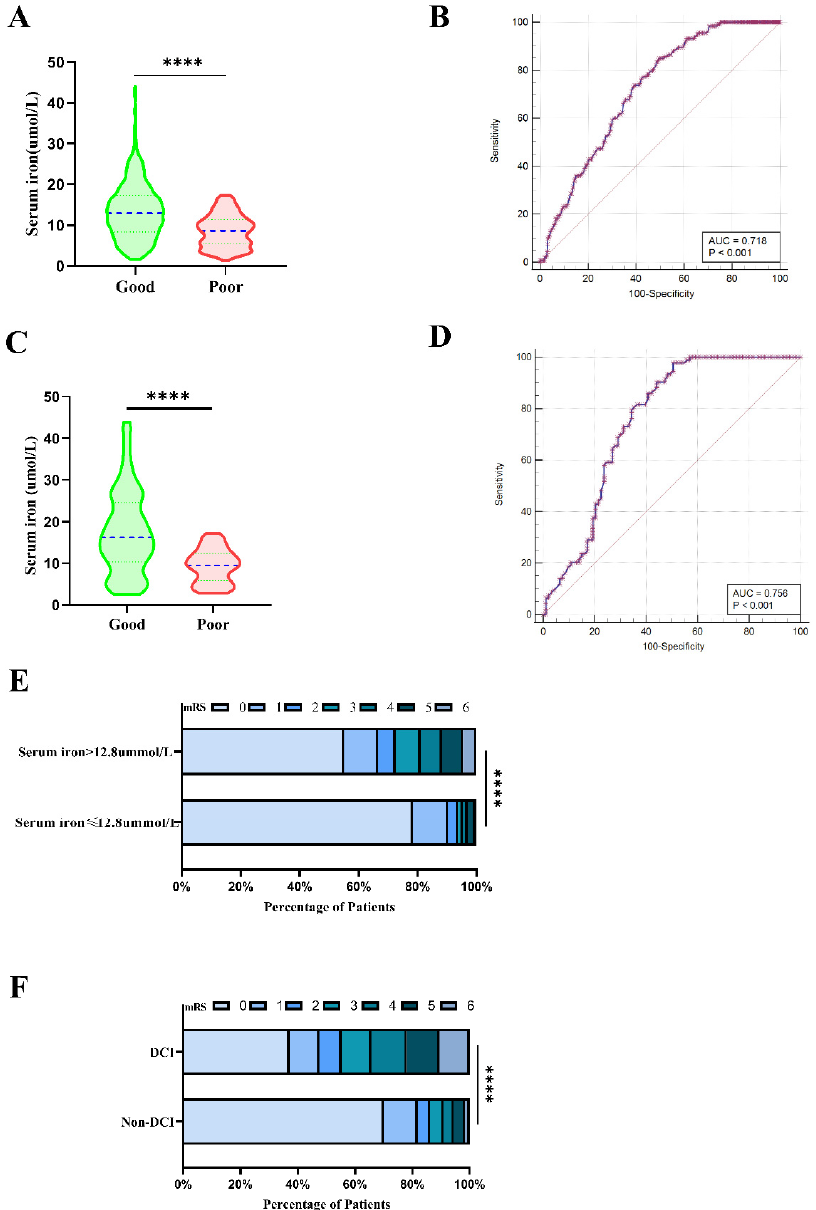
Figure 4. Associations of serum iron, DCI with outcome. ( A ) Comparison of serum iron levels in aSAH patients between good outcome and poor outcome. ( B ) ROC curve analysis of serum iron for predicting poor prognosis. The AUC of serum iron level was 0.718 (Sensitivity = 84.96%; Specificity = 50.25%) for poor prognosis based on the best threshold of 12.8 µ mol/L. ( C ) Comparison of serum iron levels in aSAH patients between good outcome and poor outcome after PSM. ( D ) ROC curve analysis of serum iron for predicting poor prognosis after PSM. The AUC of serum iron level was 0.756 (Sensitivity = 97.85%; Specificity = 49.46%) for poor prognosis based on a cut-off value of 16.3 µ mol/L. ( E ) Distribution of mRS scores at 90 days for patients with lower serum iron ≤ 12.8 µ mol/L and higher serum iron > 12.8 µ mol/L). The percentage of patients within each score category on the 7-point scale (0 indicates no symptoms and 6 indicates death) at 90 days. ( F ) Distribution of mRS scores at 90 days for patients with DCI and without DCI. The percentage of patients within each score category on the 7-point scale (0 indicates no symptoms and 6 indicates death) at 90 days. (****: p ≤ 0.0001) AUC: area under the curve; aSAH: aneurysmal subarachnoid hemorrhage; DCI: delayed cerebral ischemia; mFisher: modified Fisher; mRS:modified Rankin Scale; PSM: propensity-score matching; ROC: Receiver operating